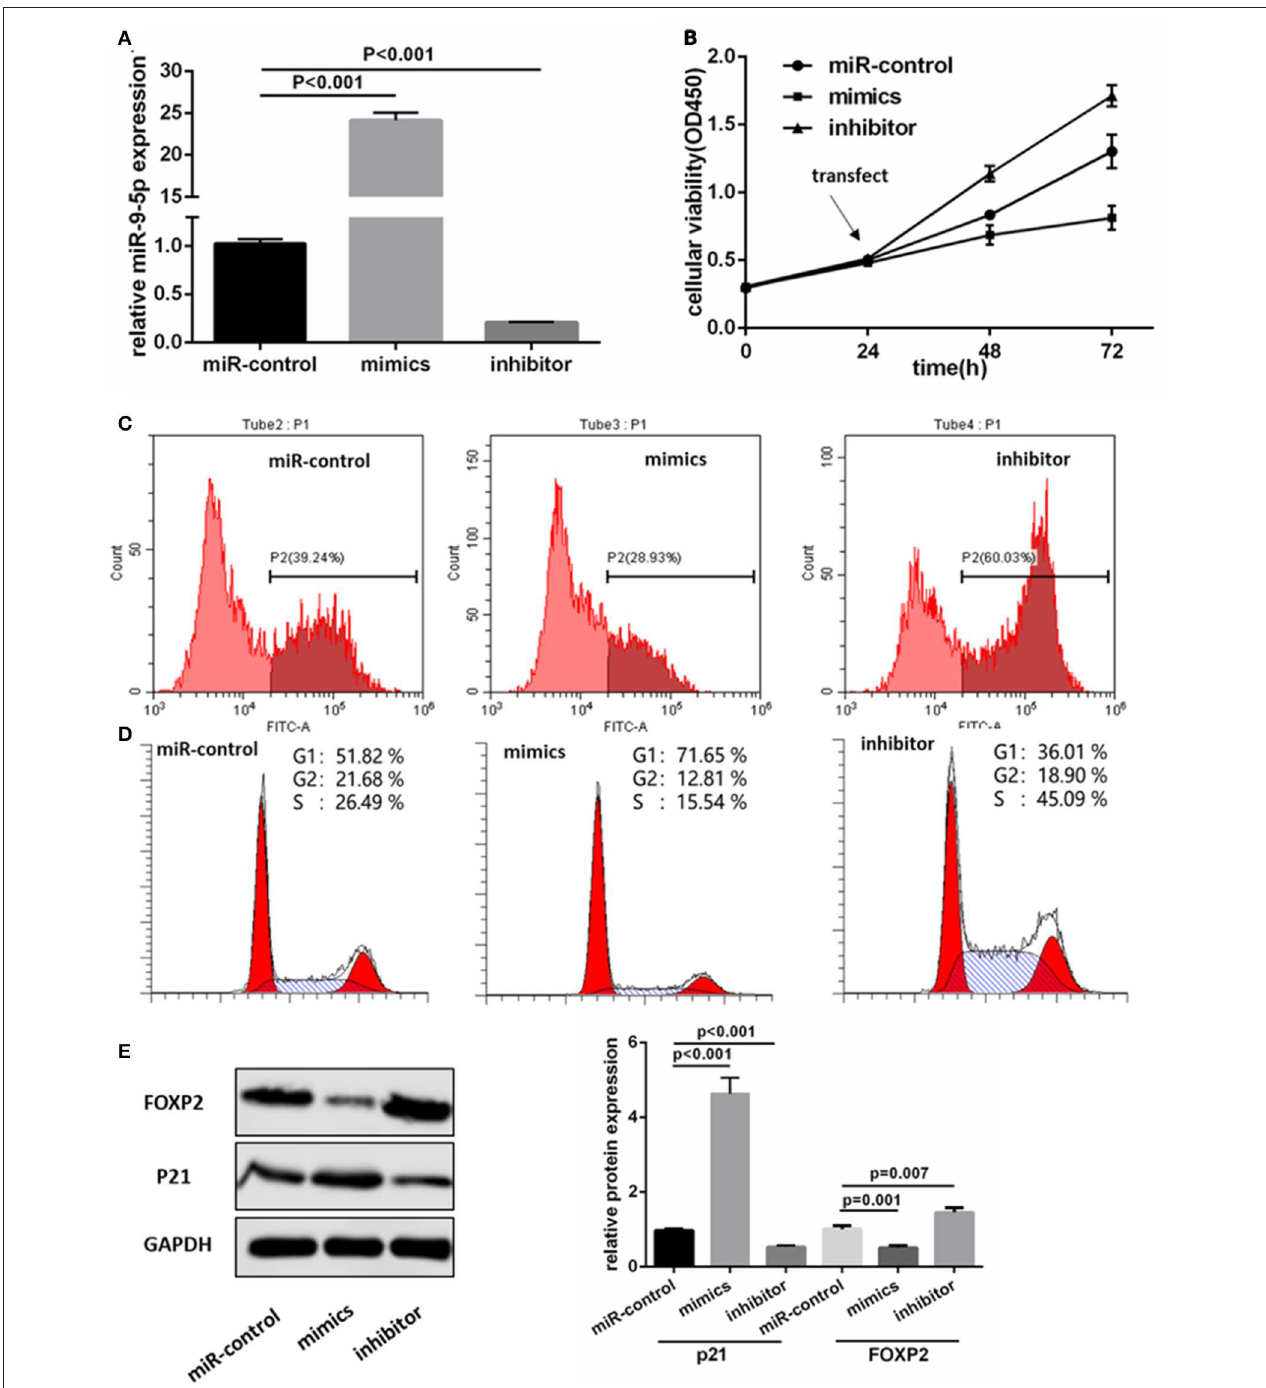
FIGURE 2 | MiR-9-5p inhibits GBM cell growth through cell cycle arrest in vitro . (A) Expression of miR-9-5p in U251 cell transfected with miRNA. (B,C) CCK-8 (B) and EdU (C) show that high expression of miR-9-5p inhibits cell growth while low expression leads to the opposite effect. (D) Cell cycle is arrested in cells with high expression of miR-9-5p analyzed by Flow cytometry. (E) Over expression of miR-9-5p leads to down regulation of FOXP2 ( p = 0.001) and up regulation of p21 ( p = 0.001); while the inhibited miR-9-5p leads to up regulation of FOXP2 ( p = 0.003) and down regulation of p21 ( p < 0.001). 2 . The cases with high expression of miR-9-5p and low divided into high expression group and low expression expression of FOXP2 showed higher overall survival rate group ( Figures 1A,B ). The clinical features and relative ( Figures 1C,D expression of miR-9-5p and FOXP2 are presented in Tables 1 ,